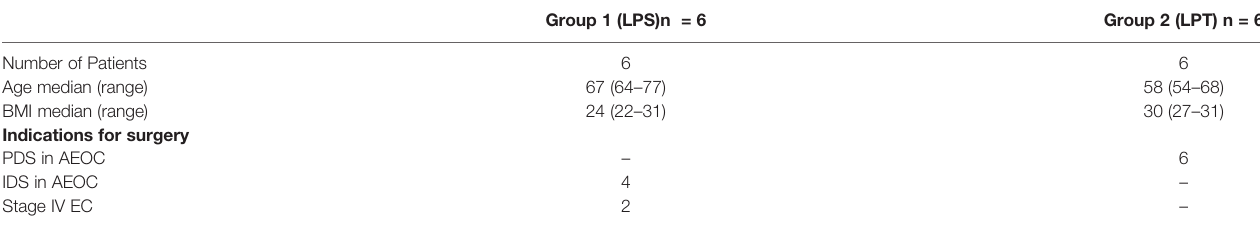
TABLE 1 | Patients ’ baseline characteristics and indications for